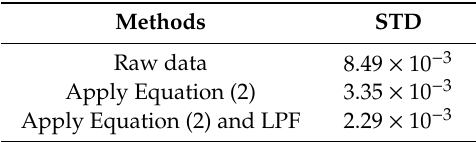
Table 1. The standard deviation (STD) by applying the referencing technique and the low-pass filter (LPF) compared to that of the raw data.